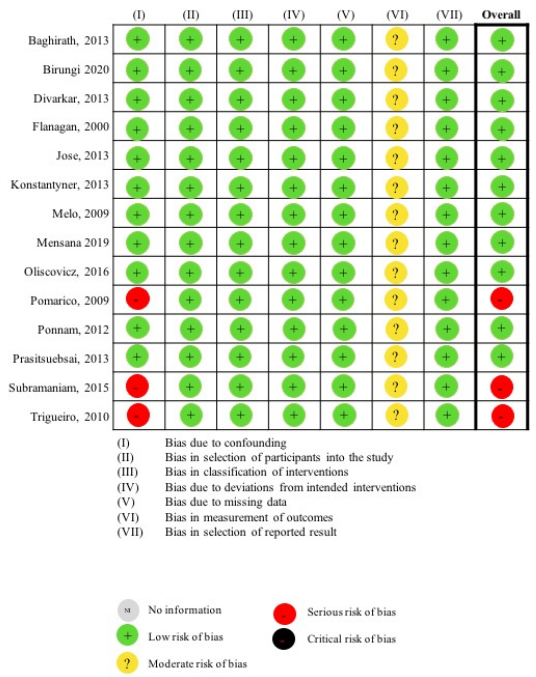
Figure 2. Risk of bias assessment with ROBINS-I [23–36].